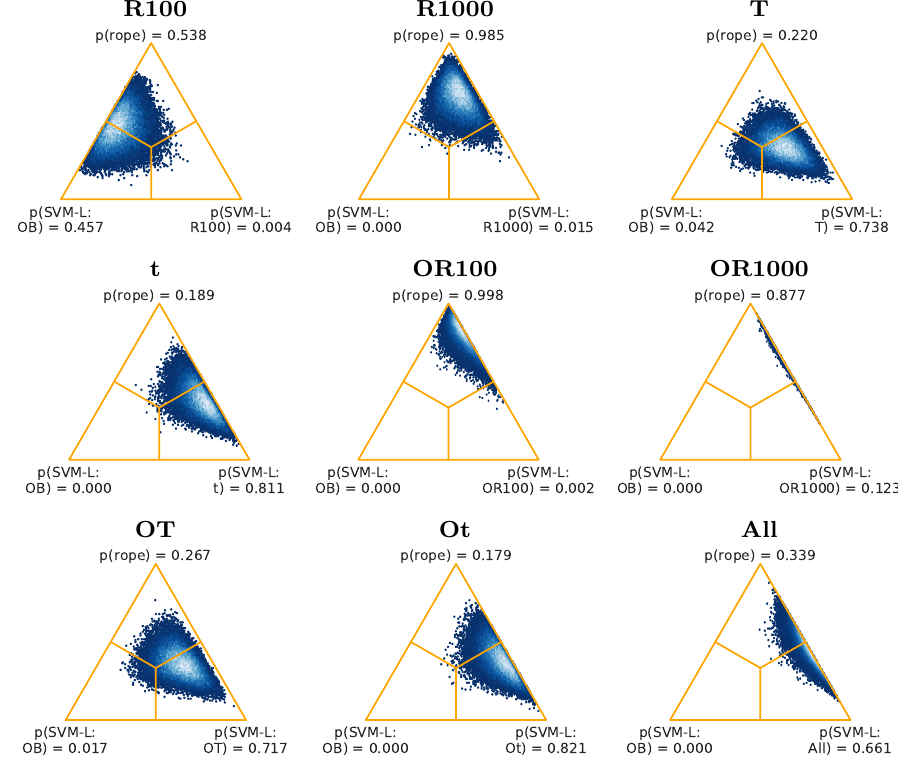
Figure 7. Posteriors for the Bayesian sign-rank tests for SVM-L, from all the